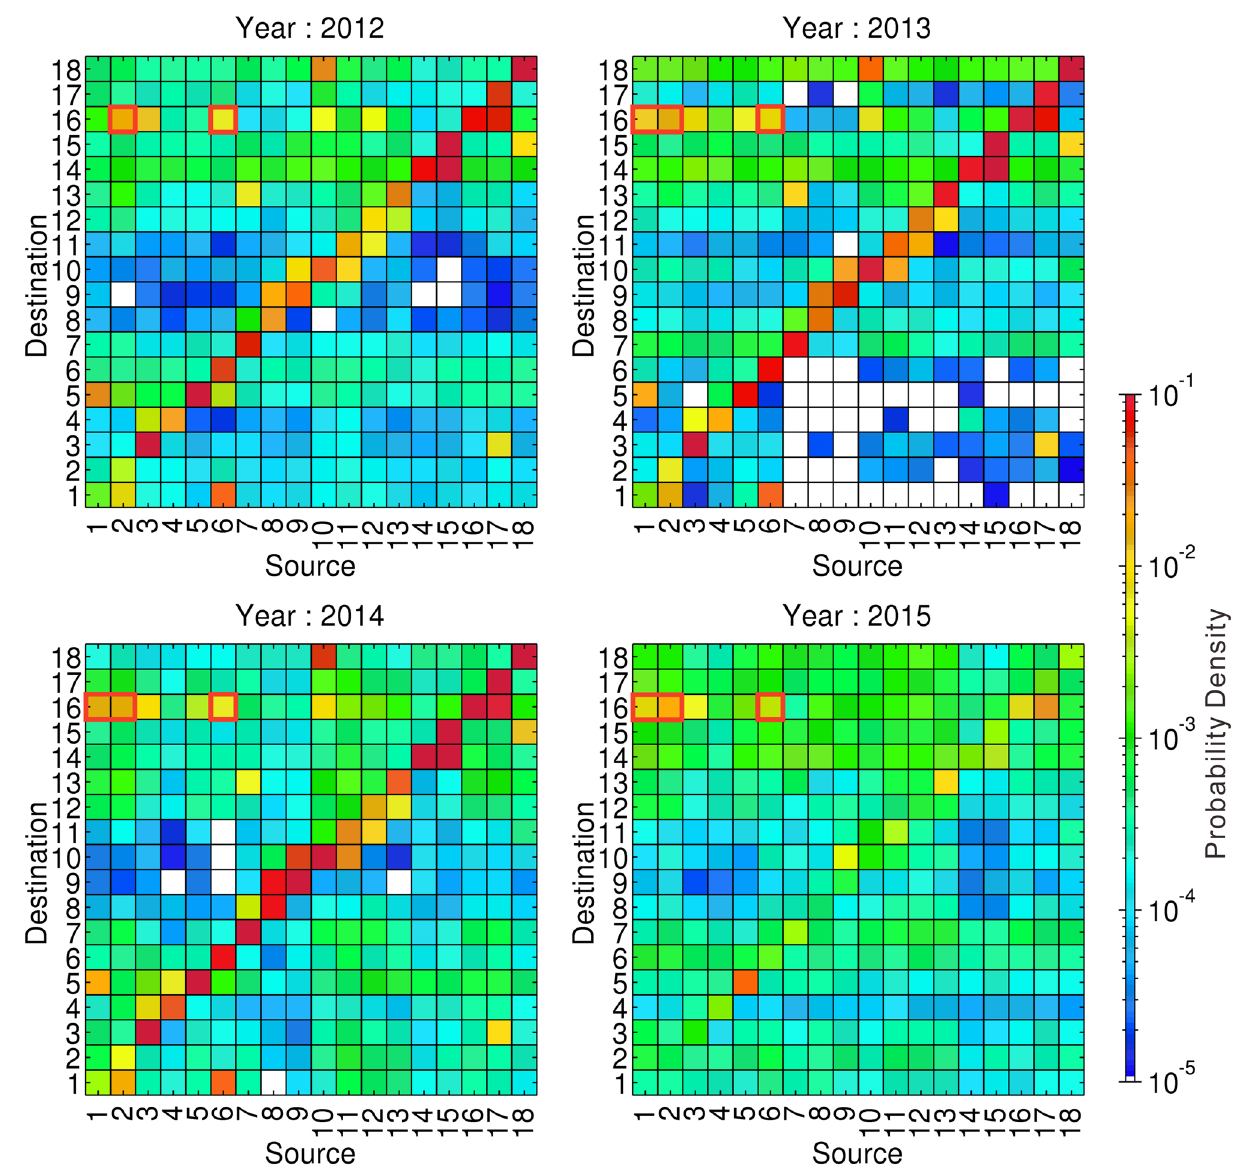
Fig. 2. High probability densities (warm colors) indicate that numerous particles drifted from the source area to the destination area. Red outlines show high-probability-density source areas outside of the lagoon (i.e., other than groups 3, 10, and 14–18) for Group